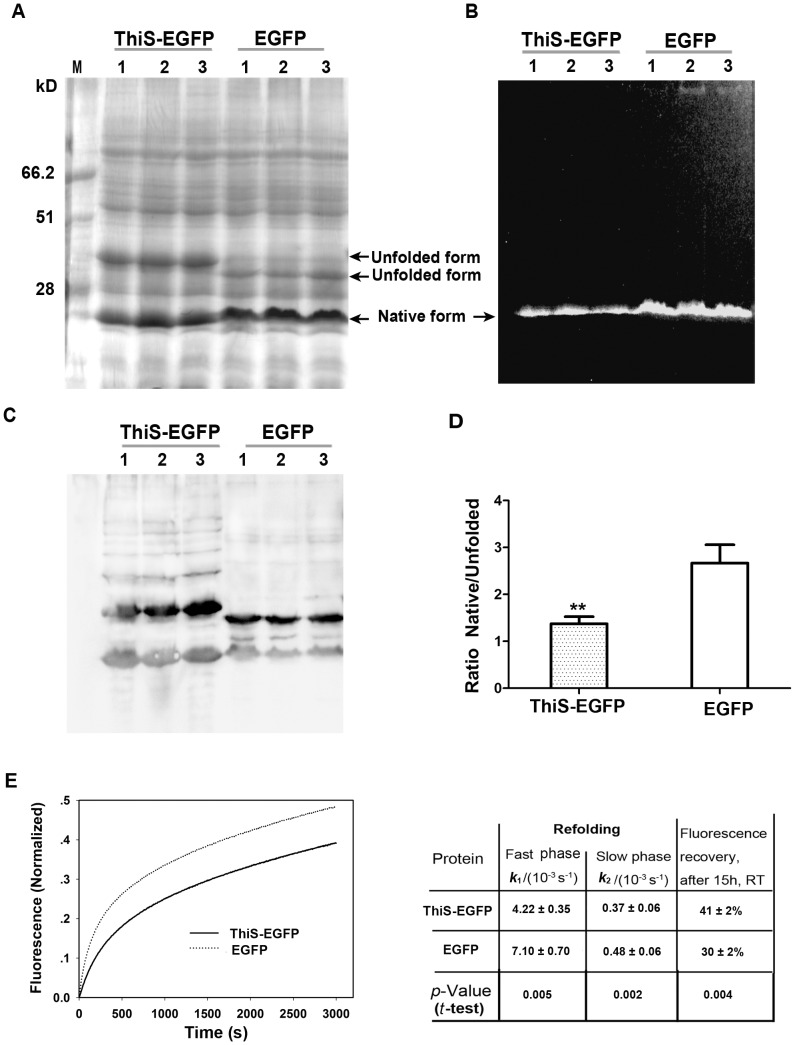
Soluble expression and in vitro refolding of EGFP proteins with or without ThiS fusion.(A) Three independent clones of E. coli TG1 bearing plasmids expressing EGFP or EGFP fused with ThiS, were induced with IPTG at room temperature for 20 h. Unboiled total cell lysates were resolved on 12% SDS-PAGE. Soluble native form and insoluble denatured form were separated, as indicated by arrows. (B) The native form was verified by UV illumination indicating retained fluorescence of corresponding bands. (C) The Western blot with His-tag antibody further confirmed the identities of overexpressed products. (D) The ratio of native form to unfolded form of ThiS-EGFP was compared to that of EGFP. ** P<0.01. (E) The refolding kinetics of both proteins was compared in vitro. Left panel represents a typical result of the short term refolding curves, with fluorescence (normalized to the respective final fluorescence recovered) plotted against time. In the right panel, kinetics of an initial fast refolding phase, the following slow refolding phase, and the percentage of refolding at final stage (15 h) were compared between two proteins from 3 independent experiments.